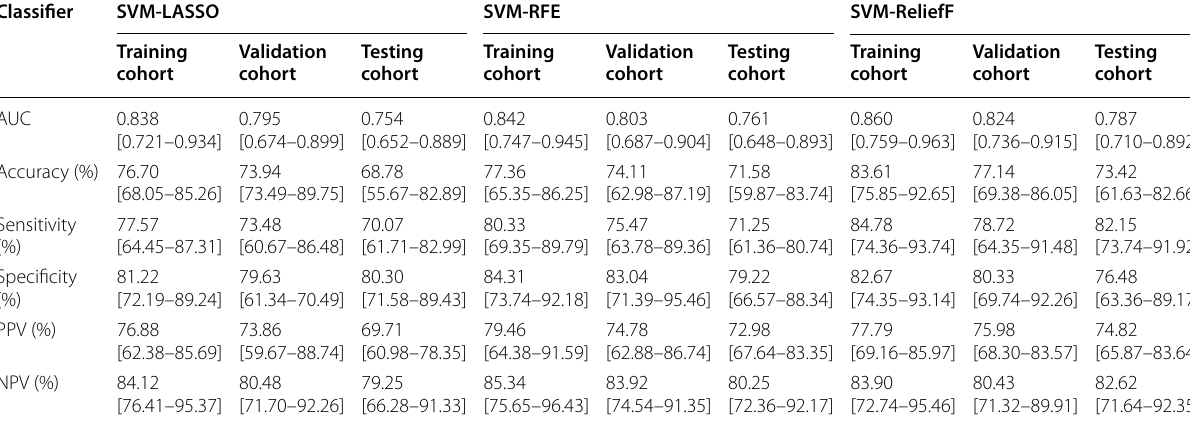
Data in parentheses are 95% confidence